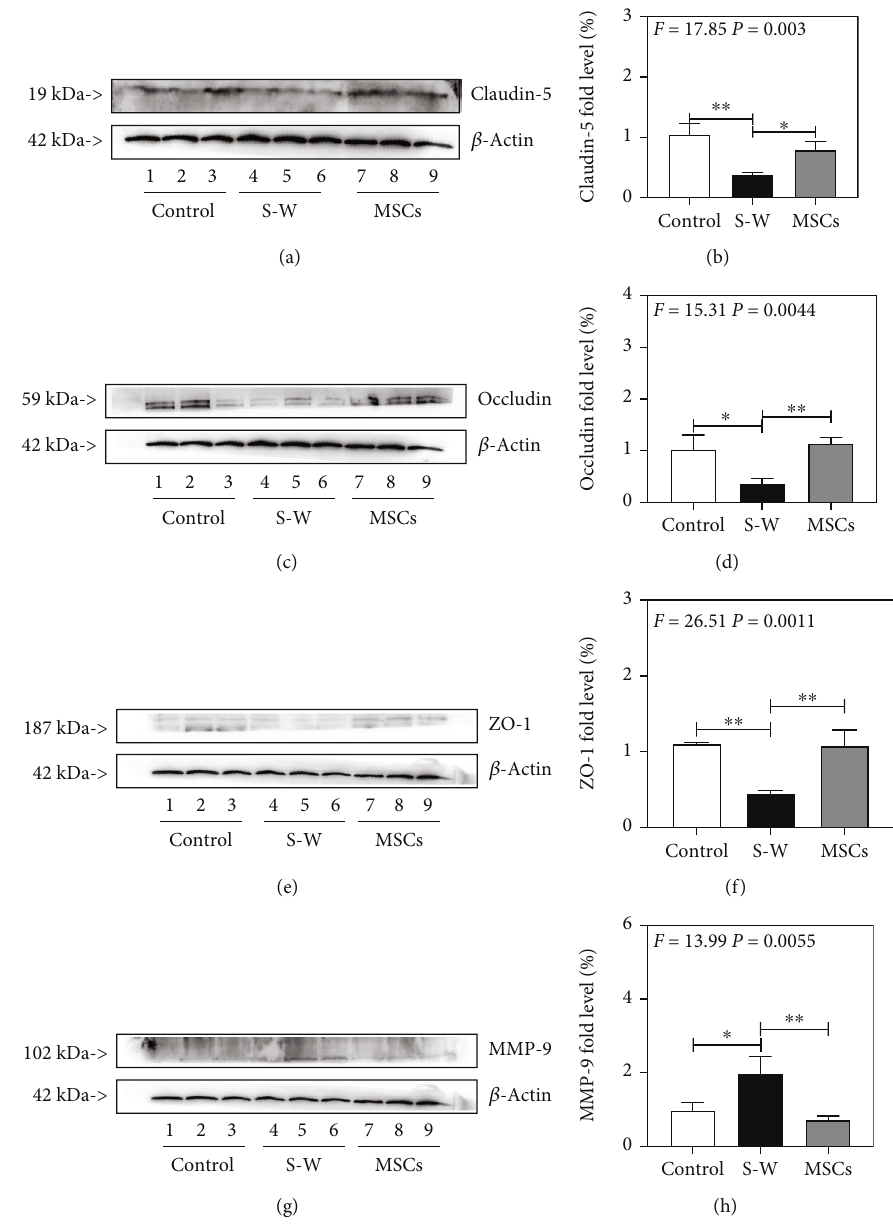
Figure 3: The expression of TJs and MMP-9 in BBB after surgical wound in control, S-W, and MSCs (12 hours before surgical wound) groups. (a, b) The expression of Claudin-5 at 6 hours after surgical wound in control, S-W, and MSCs (12 hours before surgical wound) groups. (c, d) The expression of Occludin at 6 hours after surgical wound in control, S-W, and MSCs (12 hours before surgical wound) groups. (e, f) The expression of ZO-1 at 6 hours after surgical wound in control, S-W, and MSCs (12 hours before surgical wound) groups. (g, h) The expression of MMP-9 at 6 hours after surgical wound in control, S-W, and MSCs (12 hours before surgical wound) groups. N = 3 in each group ( ∗ p < 0 : 05 , ∗∗ p < 0 : 01